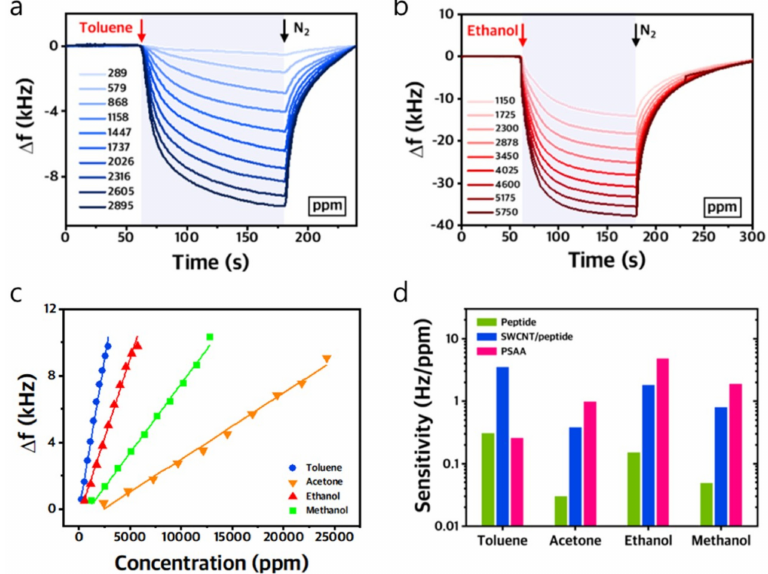
Figure 6. ( a ) Transient plot of the oscillation frequency of a CMUT sensor coated with the SWCNT/peptide layer in response to different concentrations of toluene. ( b ) Transient plot of the oscillation frequency of a CMUT sensor coated with the PSAA layer in response to different concentrations of ethanol. ( c ) Plot of maximum frequencies of the CMUT VOC sensor coated with SWCNT/peptide layer at various concentrations of four VOCs. ( d ) Plot of sensitivities of three CMUT sensors to toluene, acetone, ethanol, and